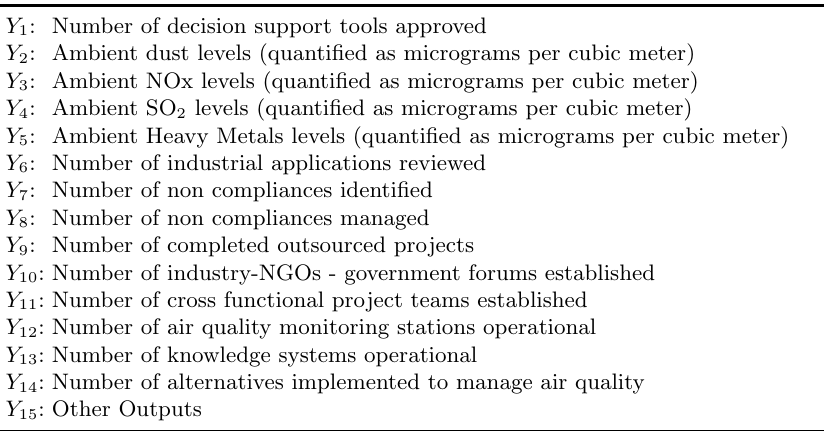
Table 2: Output variables used in this study (Air Quality Act,